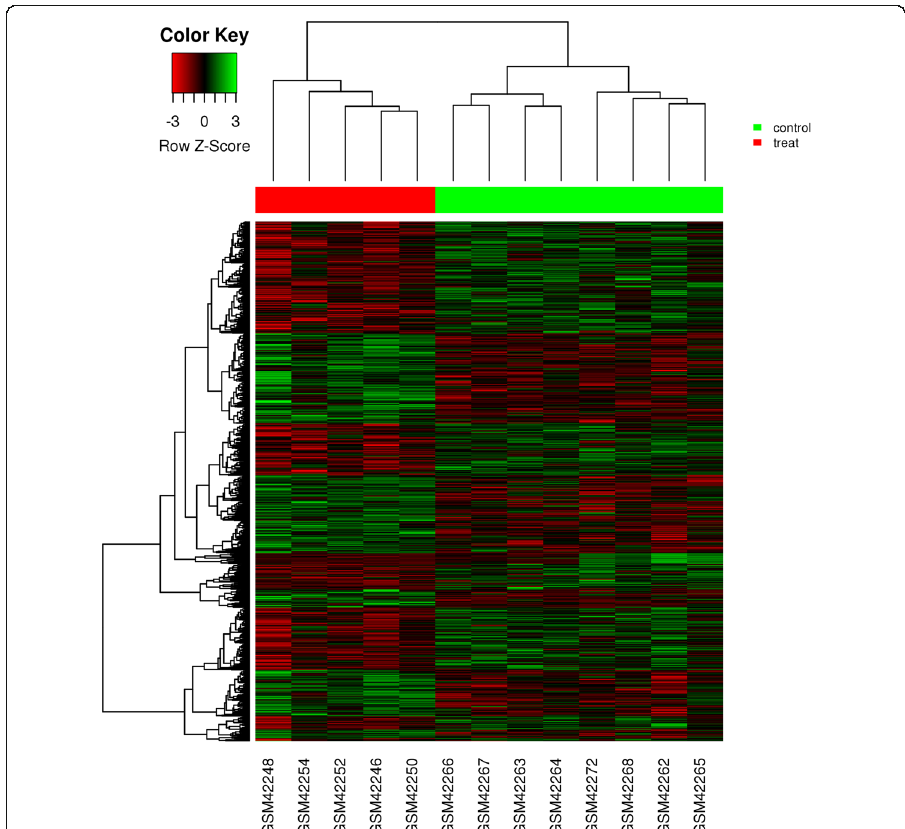
Fig. 2 Heat map of distribution of DEGs in GSE2280. The comparisons of gene expression profiles were made between primary tumors of squamous cell carcinomas of the oral cavity (OSCC) which has lymph node metastasis and nonmetastatic primary OSCC without lymph node